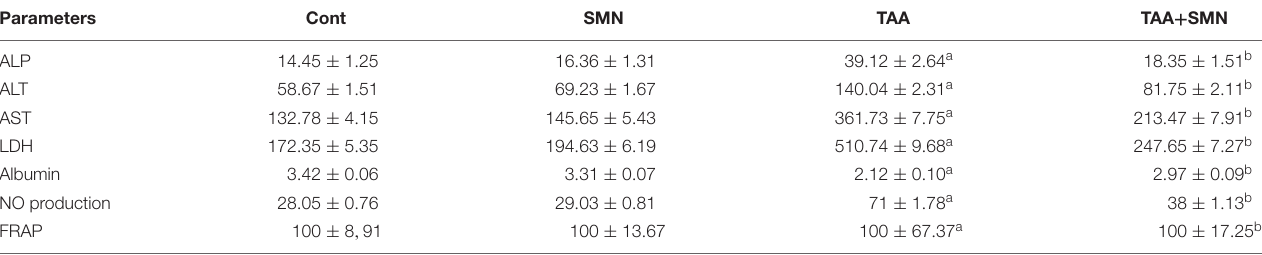
TABLE 1 | Effect of TAA and SMN on liver marker enzymes.